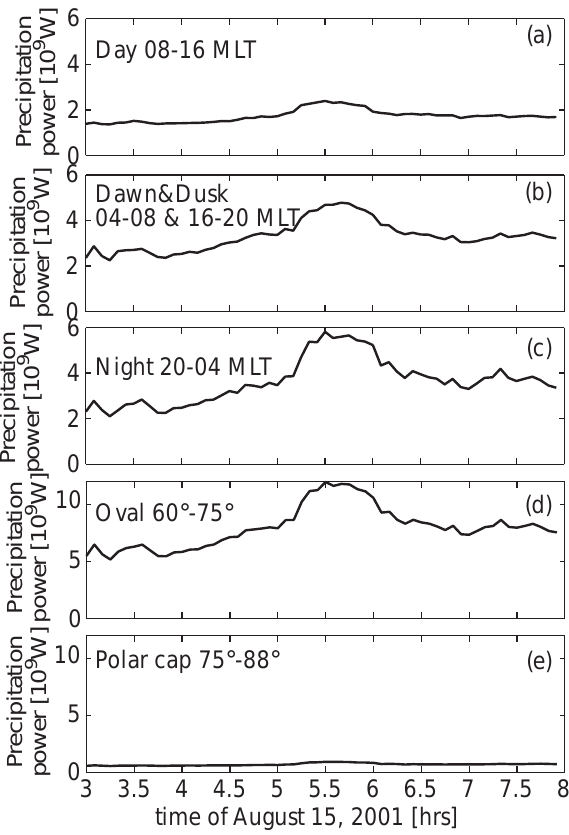
Fig. 11. Precipitation energy during the April 2000 storm in (a) the dayside 08:00–16:00 MLT, (b) dawn 04:00–08:00 MLT and dusk 16:00–20:00 MLT, (c) nightside 20:00–04:00 MLT, (d) oval latitudes 60 ◦ –75 ◦ , and (e) polar cap latitudes 75 ◦ –88 ◦ . Both hemi- spheres are present in panels.